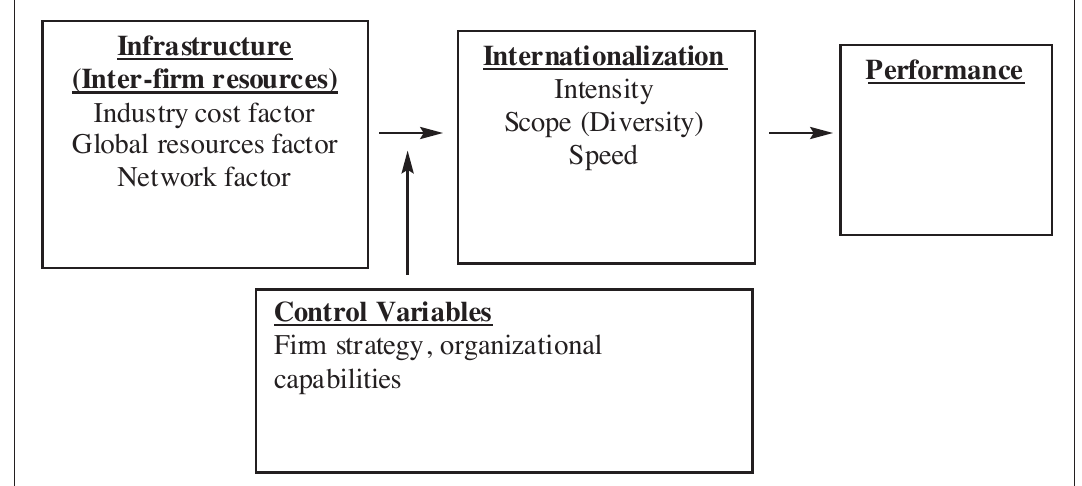
Figure 1. Model of International